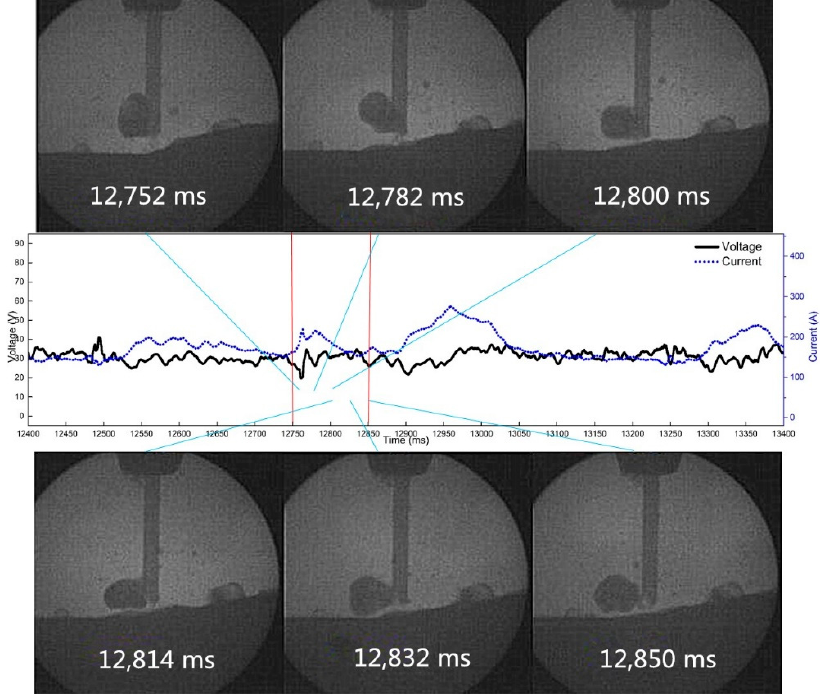
Figure 4. Droplet transition process at 40 Hz and 0.5 mm withdrawal quantity.